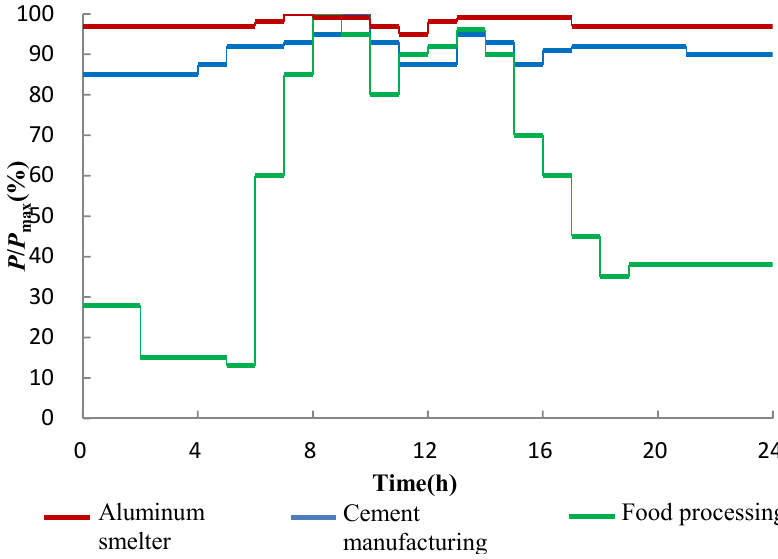
Figure 3. The daily load curve of typical industrial users in